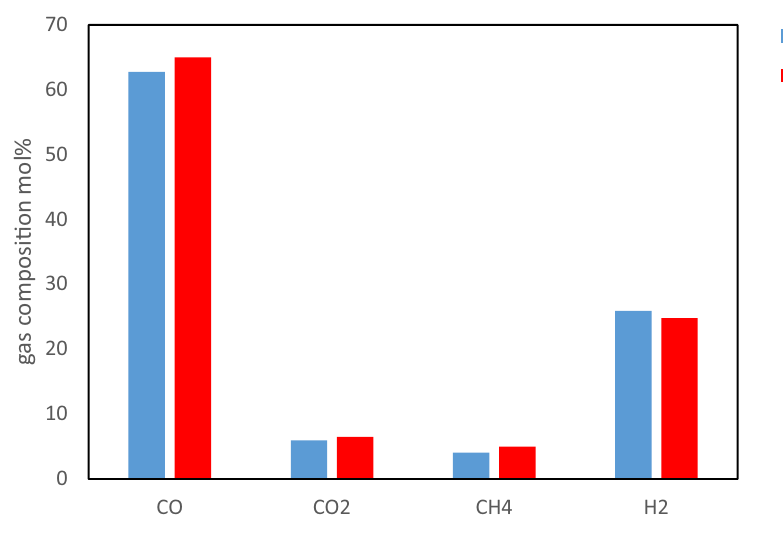
Fig. 5 Experimental and predicted syngas compositions